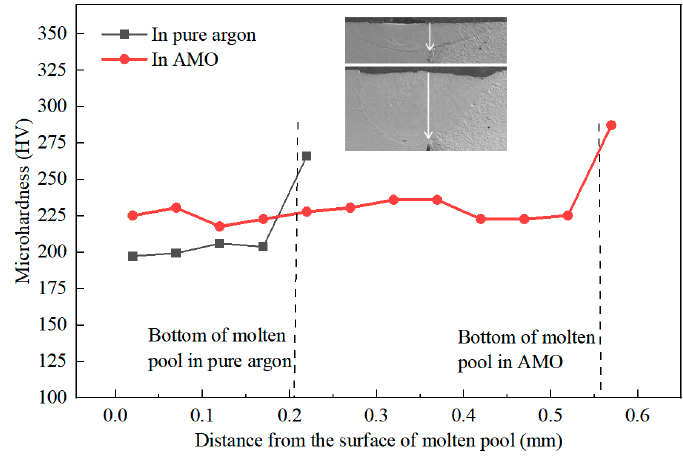
Figure 16. Microhardness distribution in the substrate interface region for welding joints in pure argon and the AMO.